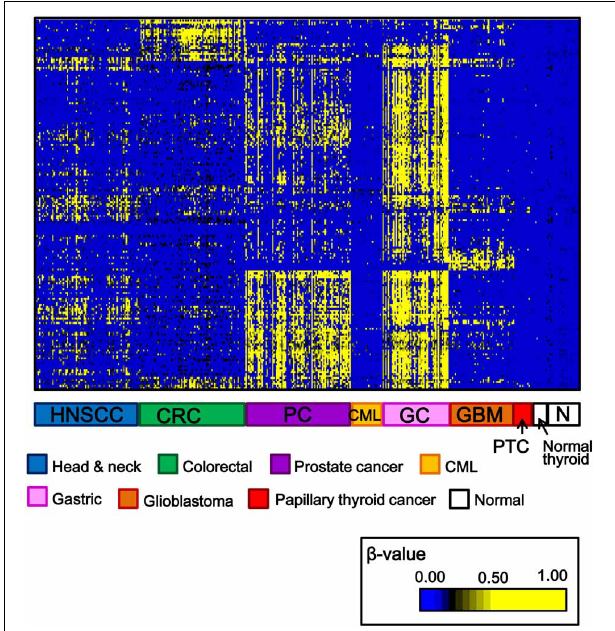
FIGURE 2 | Heatmap for methylation status of several cancer types. Genes with β -value < 0.17 in normal samples and with standard deviation of β -value in cancer samples > 0.15, were selected and their β -values were shown by heatmap. Each cancer type showed different methylation profile, and papillary thyroid cancer displayed fewer aberrantly methylated genes than other cancer types. HNSCC, head and neck squamous cell carcinoma; CRC, colorectal cancer; PC, prostate cancer; CML, chronic myeloid leukemia; GC, gastric cancer; GBM, glioblastoma; PTC, papillary thyroid cancer; N, normal samples corresponding to these cancer